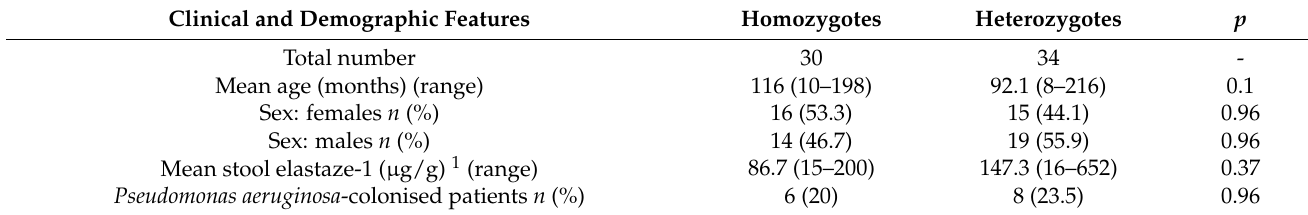
Table 2. Clinical and demographic features of the subjects in the homozygous and heterozygous groups. Clinical and Demographic